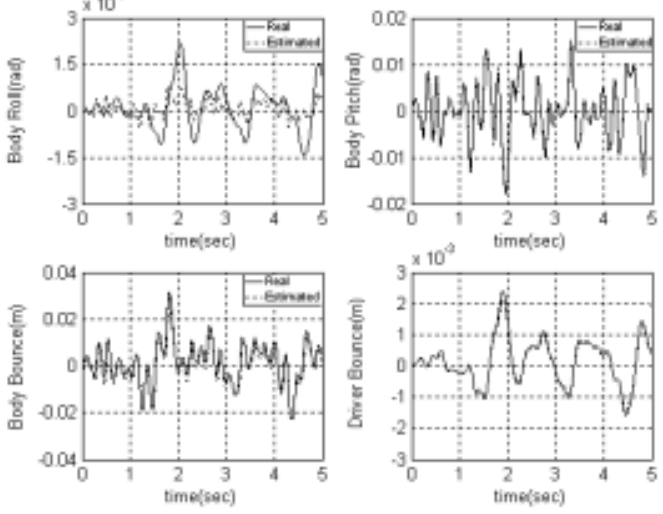
Fig. 4. Comparison of real and estimated states including body roll, body pitch, body bounce, and driver bounce.